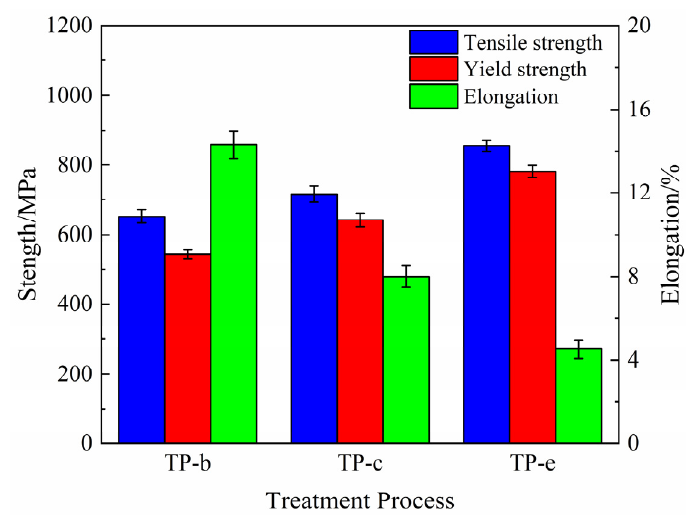
Figure 4. Tensile and yield strength of the NS-4 alloy with di ff erent combined aging treatments.